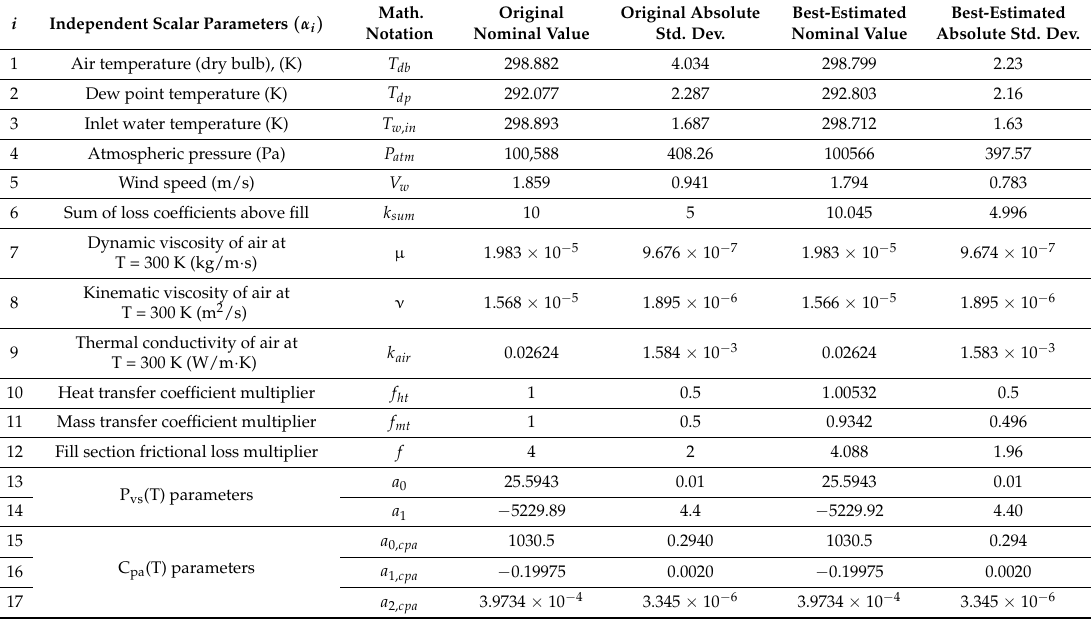
Table 12. Best-estimated nominal parameter values and their standard